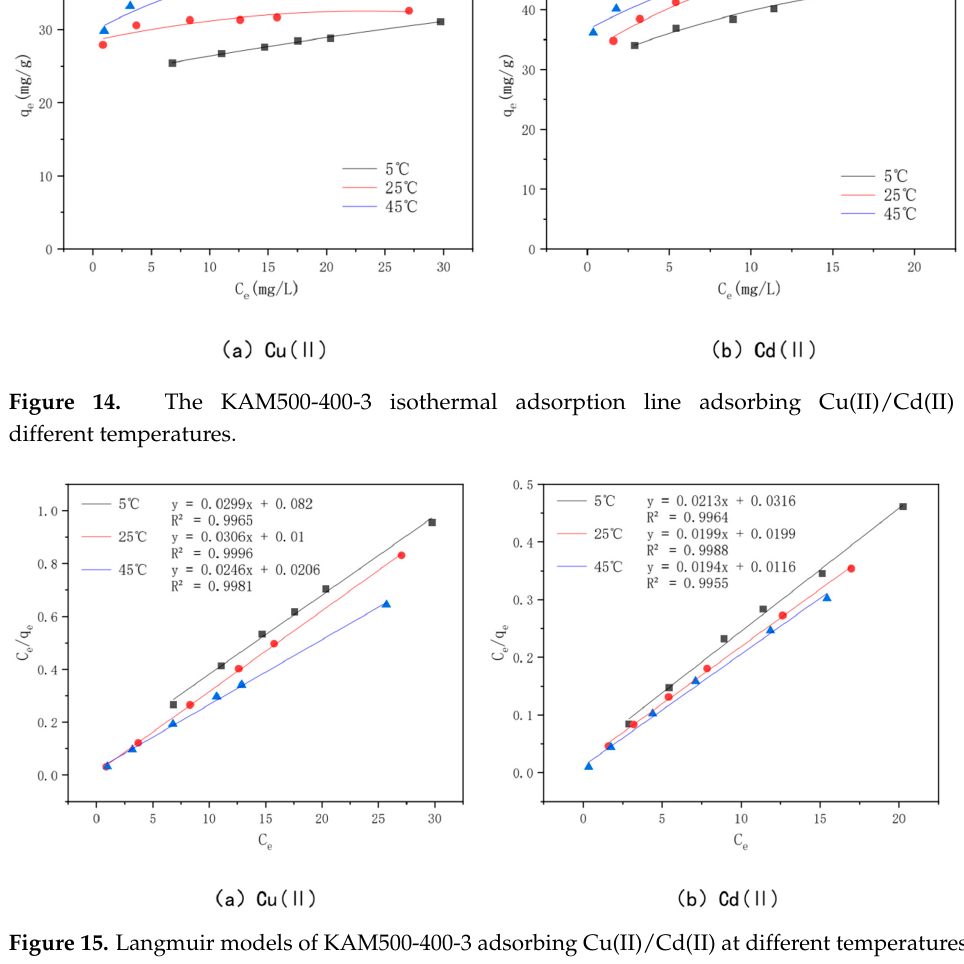
Figure 15. Langmuir models of KAM500-400-3 adsorbing Cu(II)/Cd(II) at different temperatures.